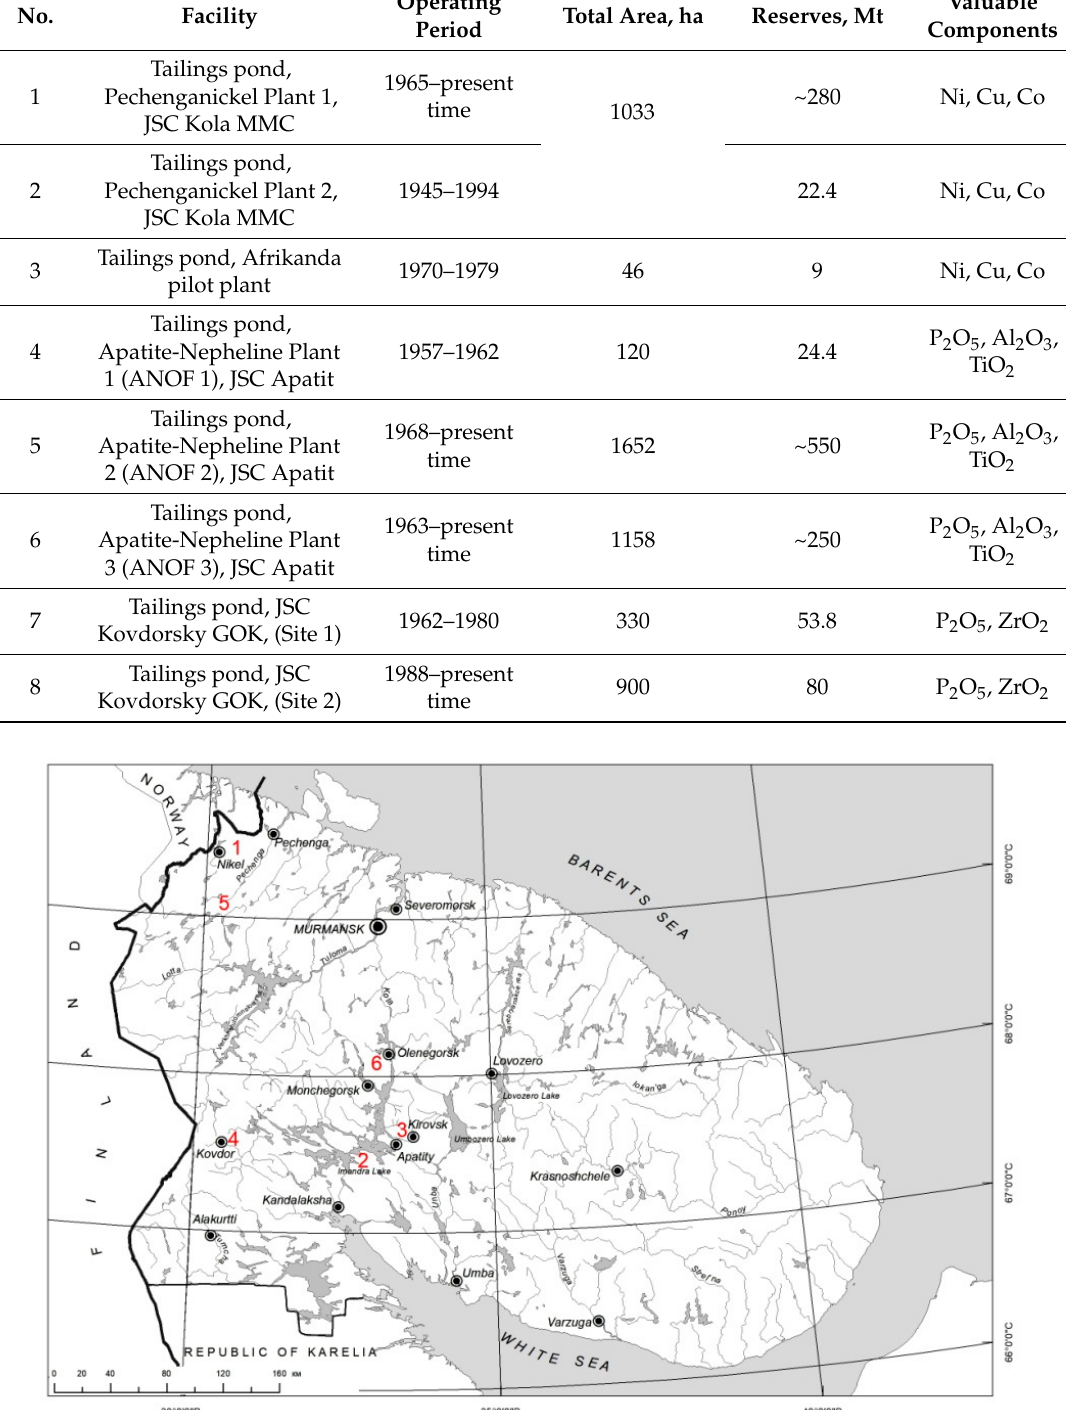
Figure 1. Location map of the mining and mineral processing waste (MMPW) sites. 1—tailings pond, Pechenganickel Plant, 2—tailings pond, Afrikanda pilot plant, 3—tailings pond, Apatite-Nepheline Plant, 4—tailings pond, JSC Kovdorsky GOK, 5—Allarechensk Copper-Nickel Mining Waste Dump, 6—overburden rock of the Olenegorsky iron ore deposits. Table 1. Selected tailings ponds in Murmansk Region.